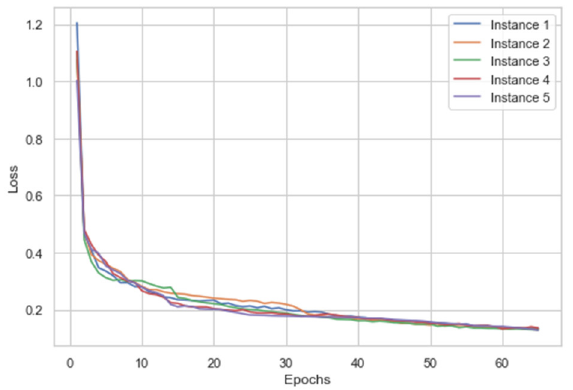
Figure 12. Training loss for the five instances.